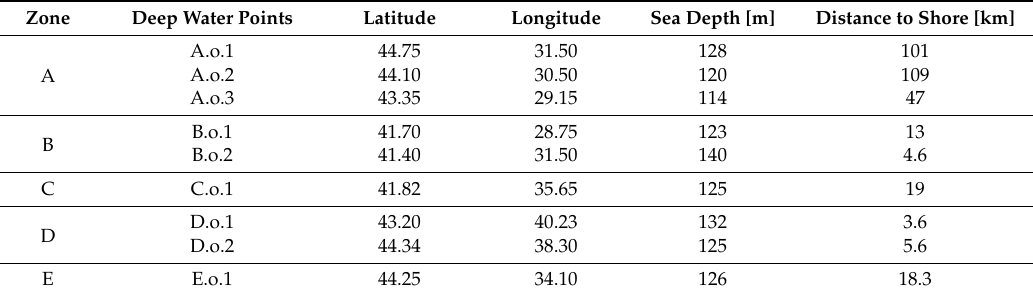
Table 2. The geographical locations and the characteristics of the deep water points.